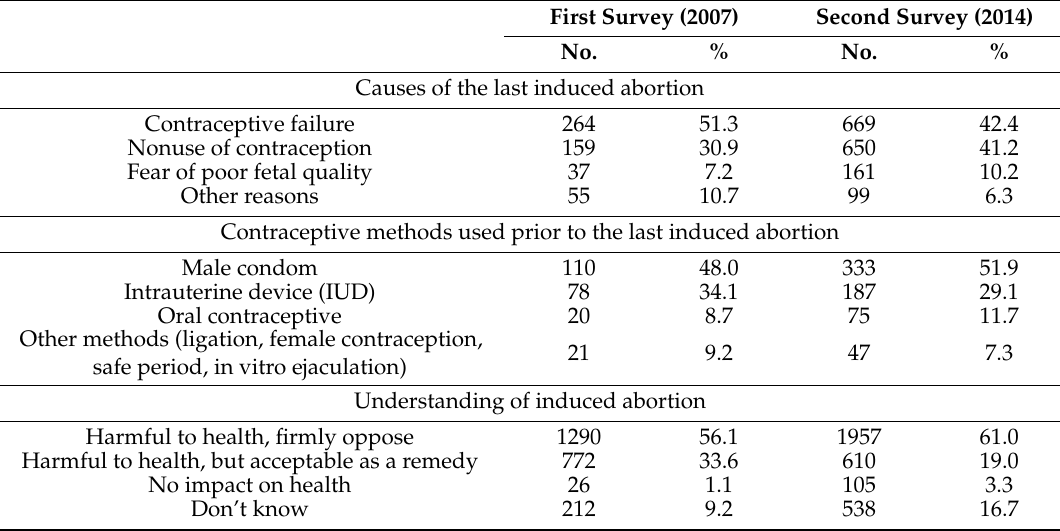
Table 2. The causes of the last induced abortion, contraceptive methods used prior to the last induced abortion, and understanding of induced abortion.